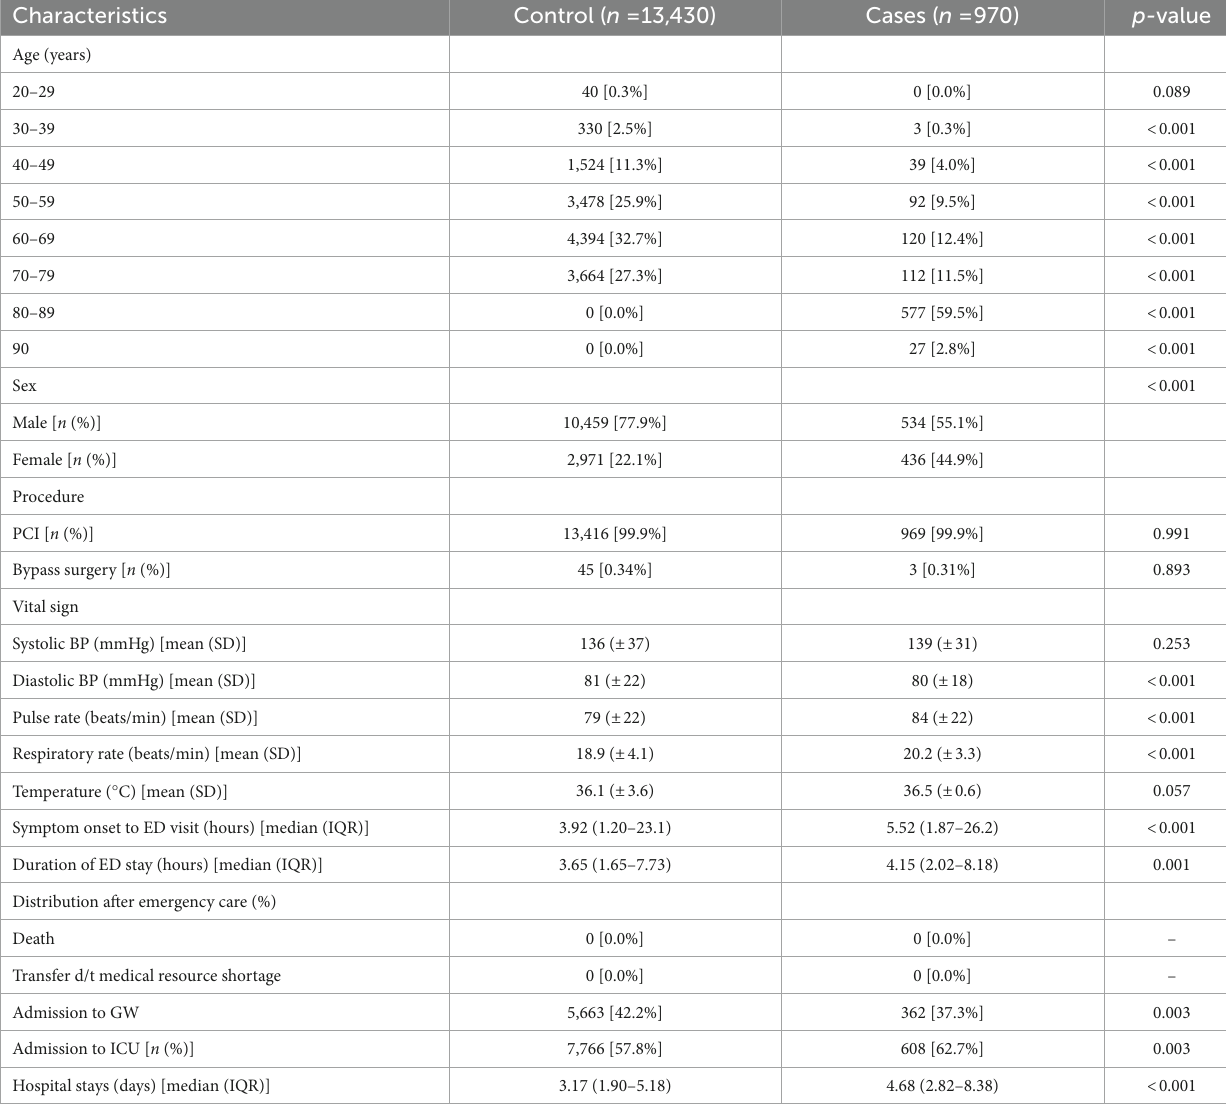
TABLE 3 Baseline characteristics in patients with and without combined comorbidities during the outbreak period.